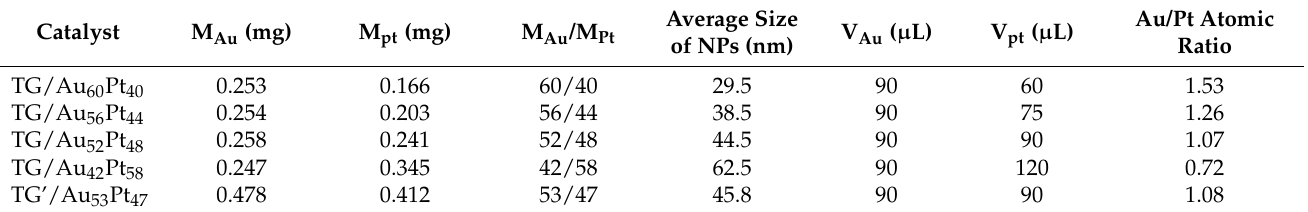
Figure 2. Characterization of the TG/Au 52 Pt 48 catalyst: ( a ) TEM image; ( b ) TEM-EDS mapping images for C, Au, and Pt; and ( c ) XRD pattern. Table 1. ICP-MS results of TG/Au x Pt y catalysts. V Au and V Pt are the adding volumes of HAuCl 4 and H 2 PtCl 6 precursor solutions,